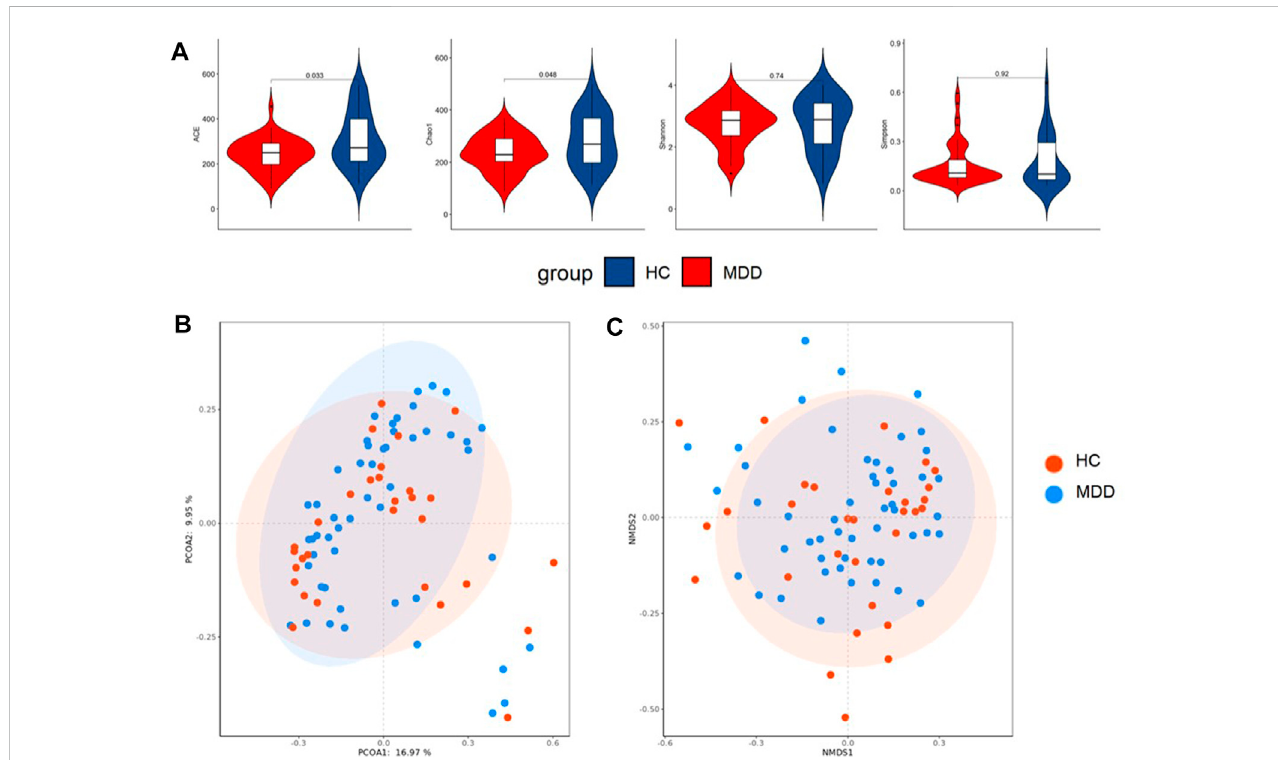
FIGURE 3 (A) Difference in alpha diversity between MDD and HC. (B) Result of principal co-ordinates analysis (PCoA) of beta diversity. (C) Result of non-metric multidimensional scaling (NMDS) of beta diversity.